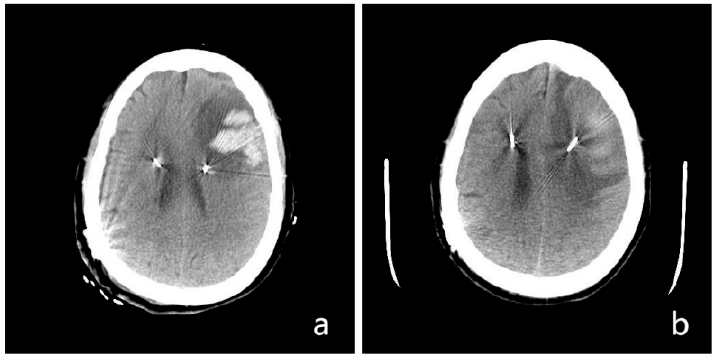
Figure 2. DBS operation with intracranial hemorrhage: ( a ) left frontal hematoma at 1 day post operation; ( b ) the hematoma was mostly absorbed at 21 days post operation.